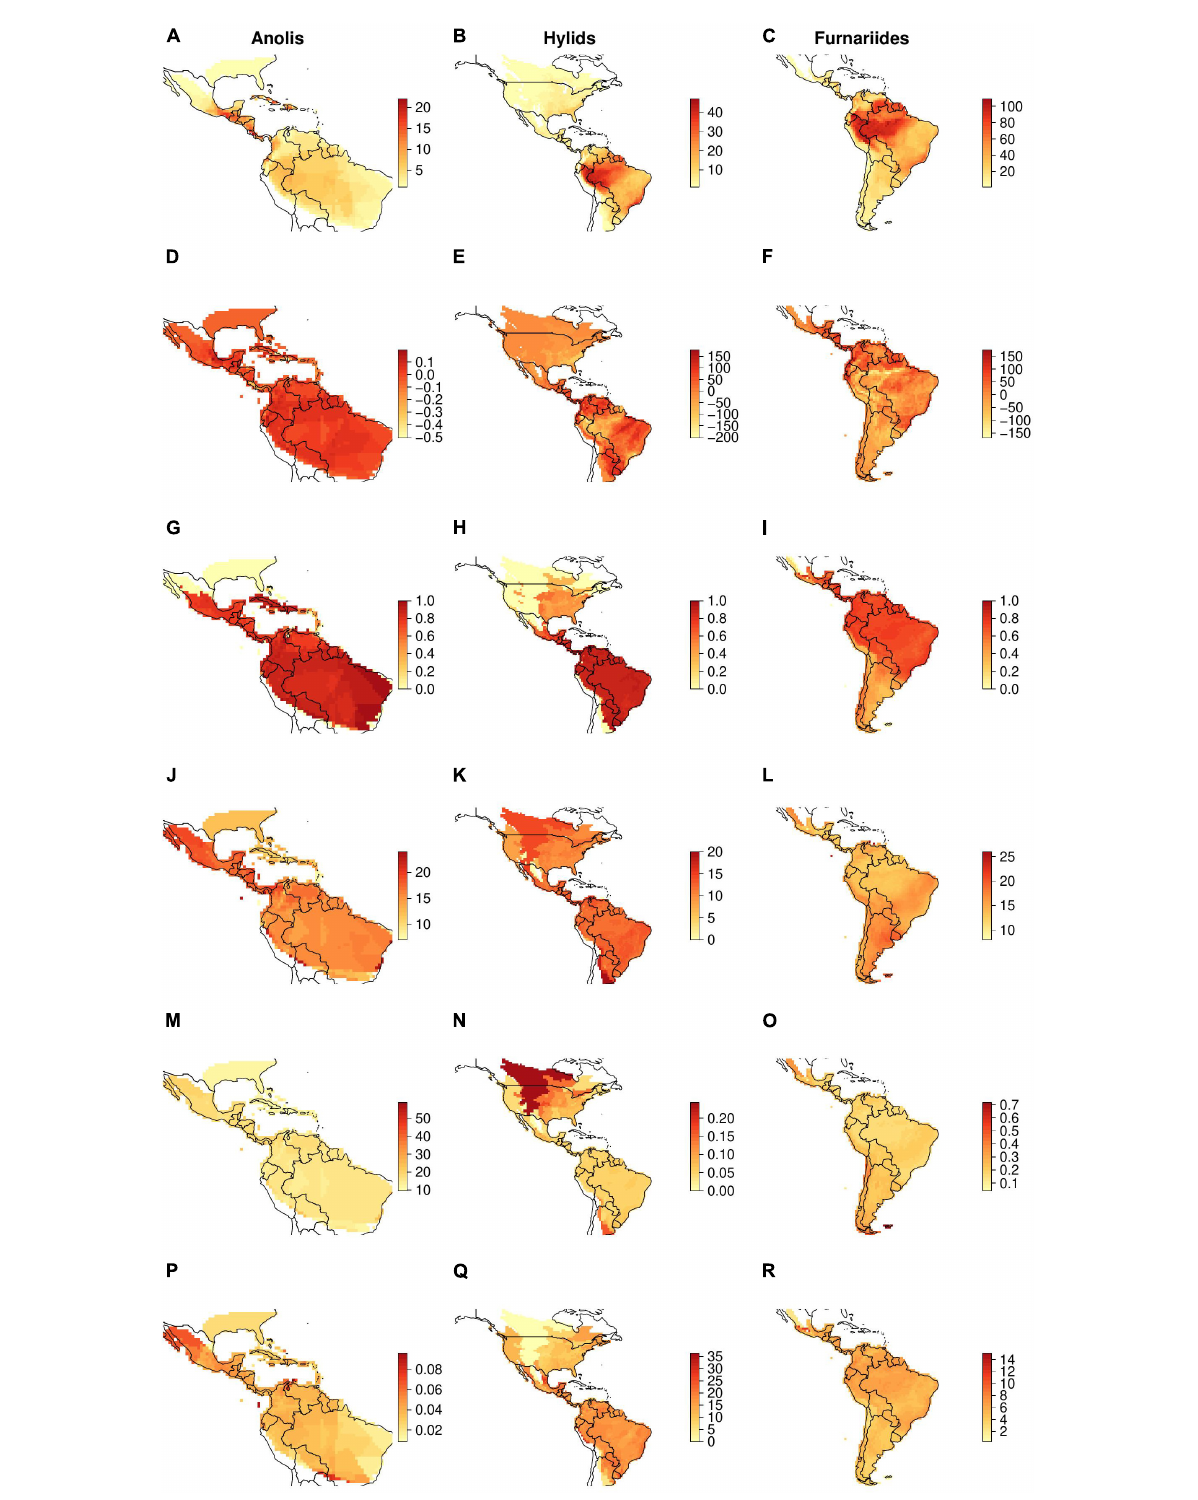
FIGURE1 Geographical patterns of several phylogenetic metrics used in macroecological studies to explore evolutionary processes underlying geographical diversity gradients (also see Table 1 for a detailed explanation). Left column, Anolis lizards; middle column, hylid frogs; right column, Furnariides birds. (A–C) observed richness patterns; (D–F) rPD, residual phylogenetic diversity (i.e., after controlling for species richness); (G–I) PSV, phylogenetic species variability; (J–L) MRD, mean root distance; (M–O) mDR, mean diversification rate; (P–R) mAges, average ages of